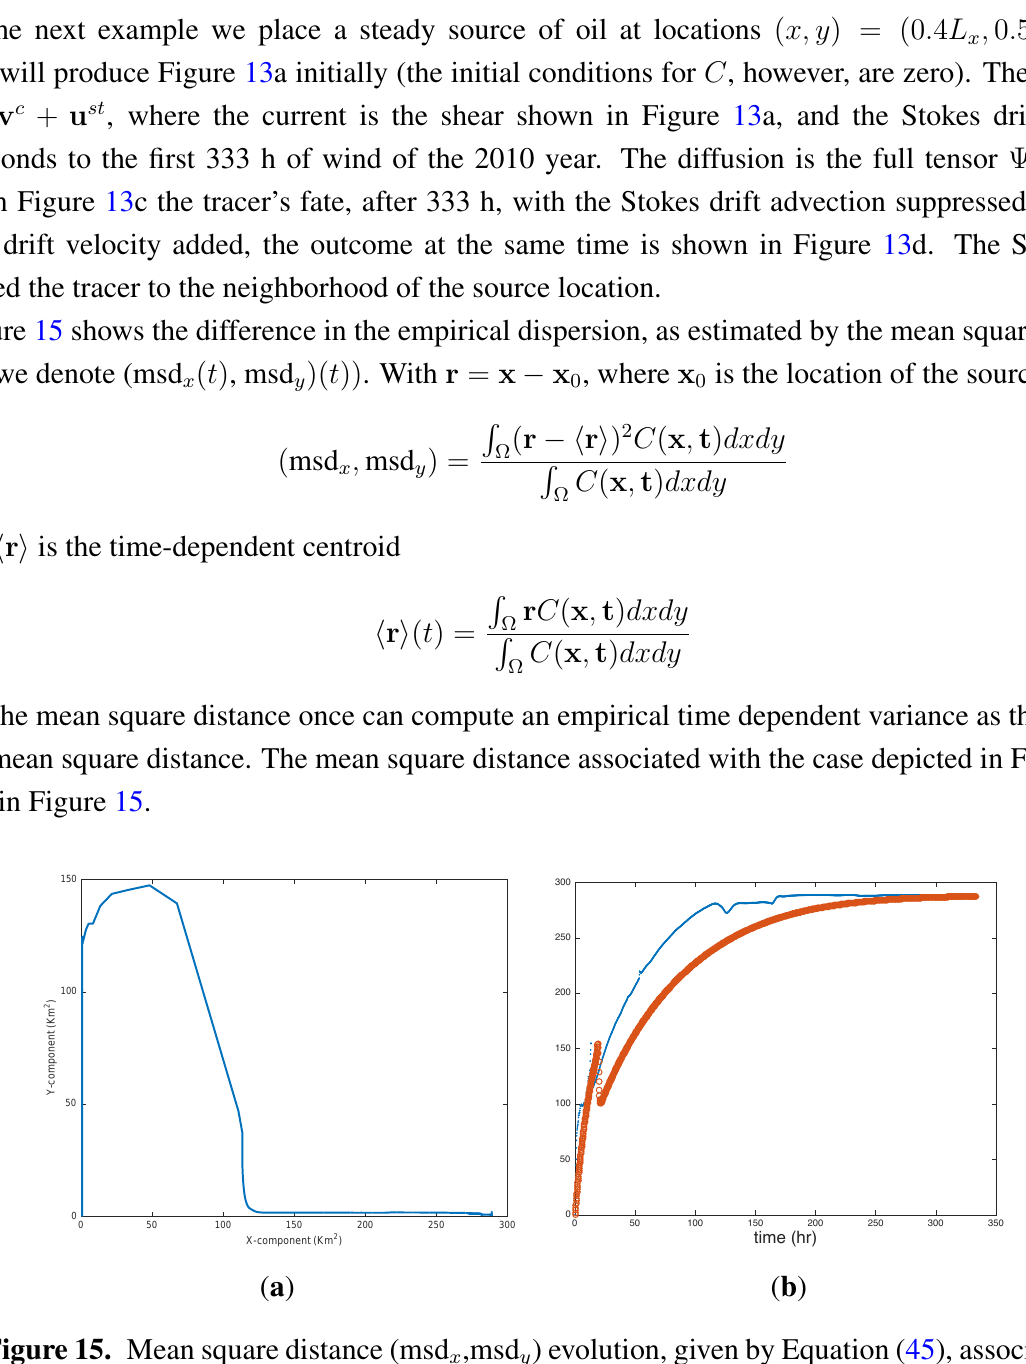
Figure 15. Mean square distance (msd with case shown in Figure 13d; ( b ) empirical variance, as a function of time, associated with Figure 13c (thick line) and Figure 13d (thin